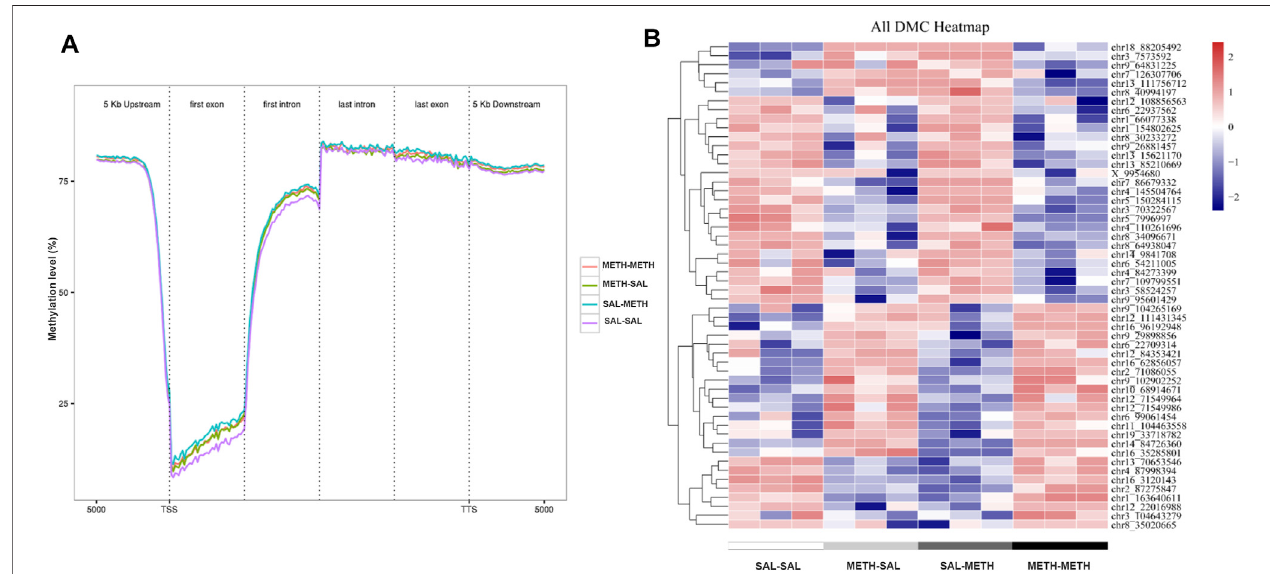
FIGURE 3 | DNA methylation dynamics in NAc of mice prenatal or postnatal METH exposure conditions. (A) Averaged methylation level pro fi les of all differentially methylated CpG sites (DMCs) from 5 Kb upstream of transcription start sites (TSS), through scaled gene bodies (exon and intron) to 5 Kb downstream of transcription termination sites (TTS). (B) Hierarchical clustering of differentially methylated CpG in NAc of prenatal or postnatal saline/METH exposure mice relative to corresponding control mice. Hyper- and hypomethylated CpG are represented in red and blue color, respectively. Data in each group are based on n =